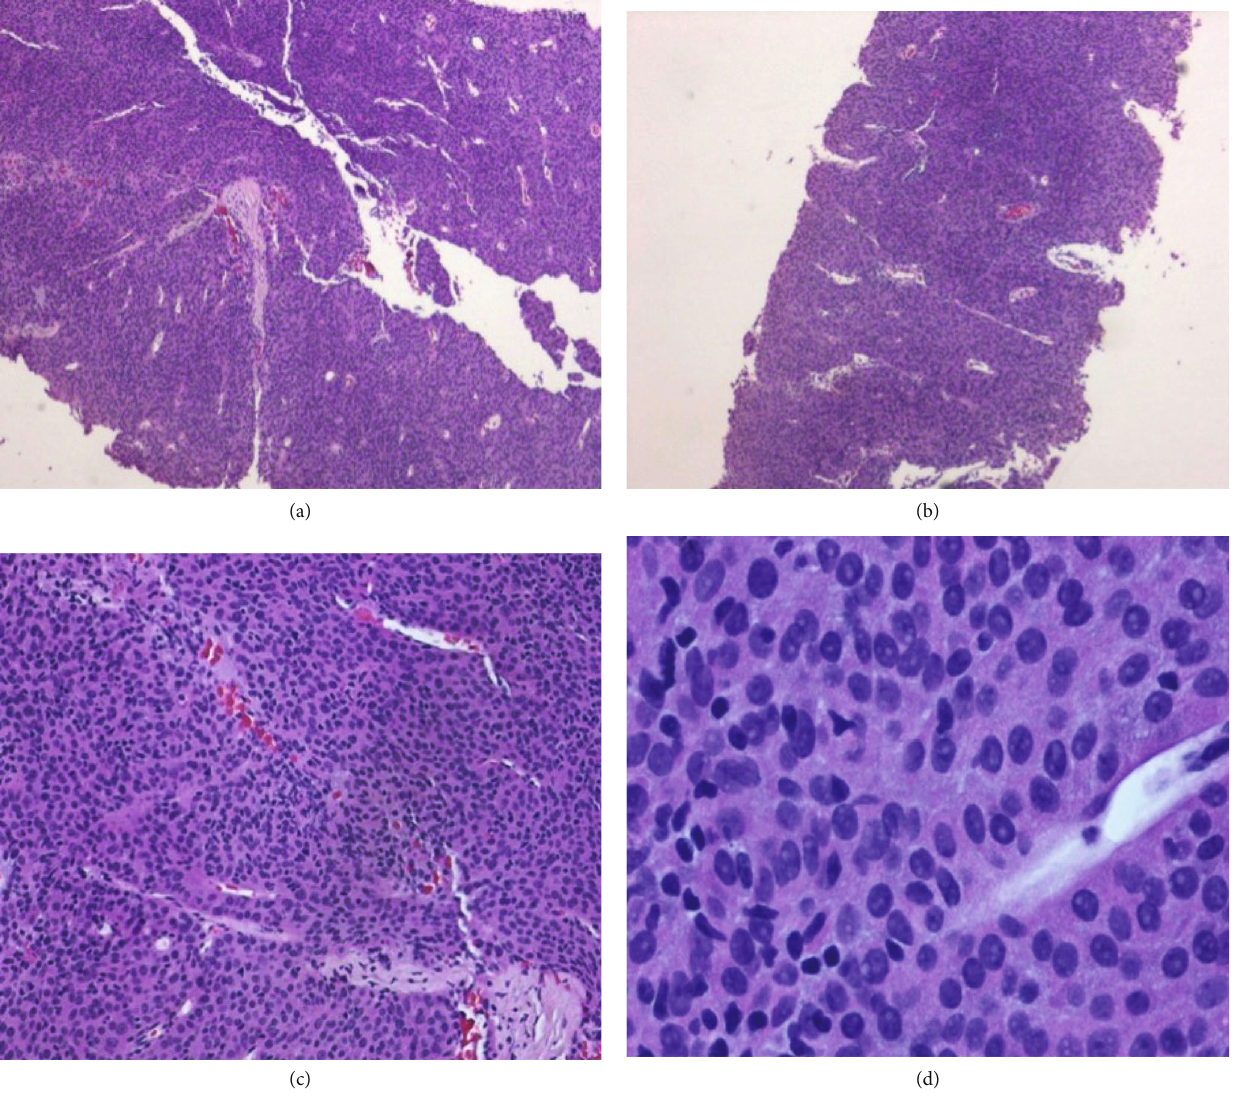
Figure 4: On histology, the lesional tissue is composed of (a) and (b) tumour tissue arranged in anastomosing smooth contoured islands, Hematoxylin & Eosin stain (H&E) × 40. (c) Absence of duct/glandular formation, H&E × 100. (d) Tumour cells have round to oval nuclei, inconspicuous nucleoli, and indistinct cell membrane, H&E ×